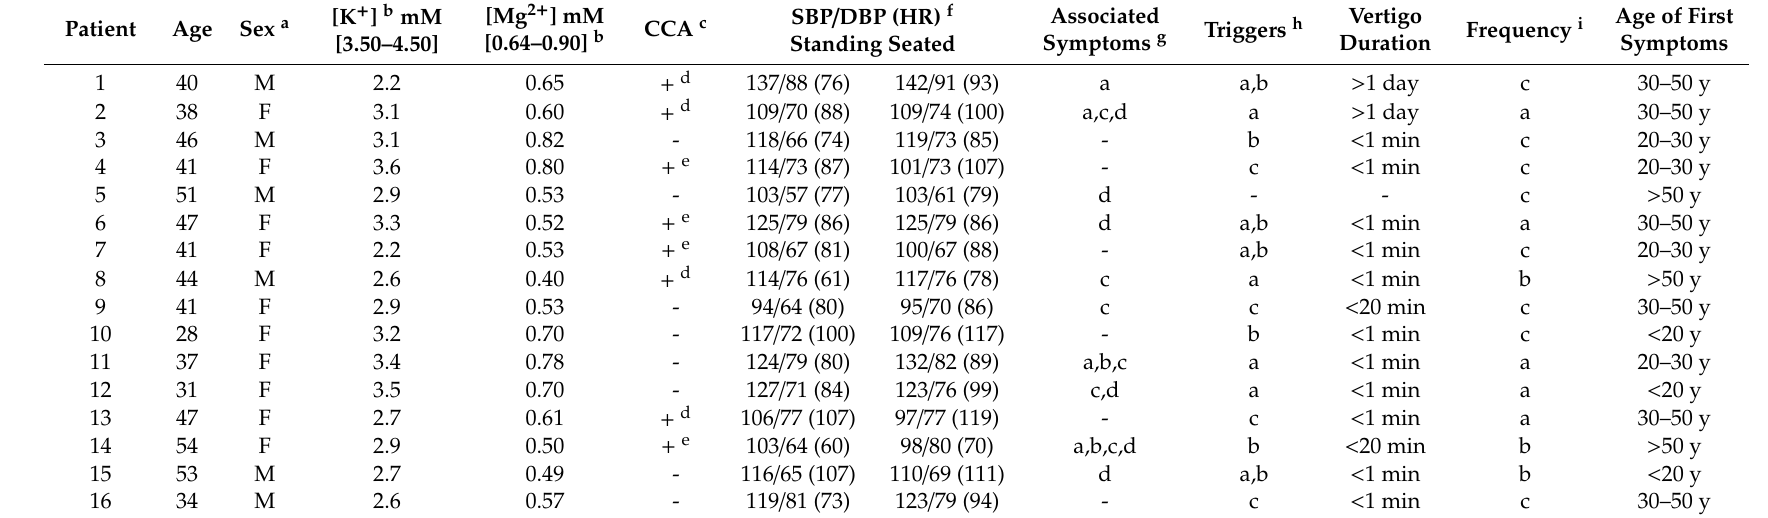
Table 1. Clinical characteristics of the